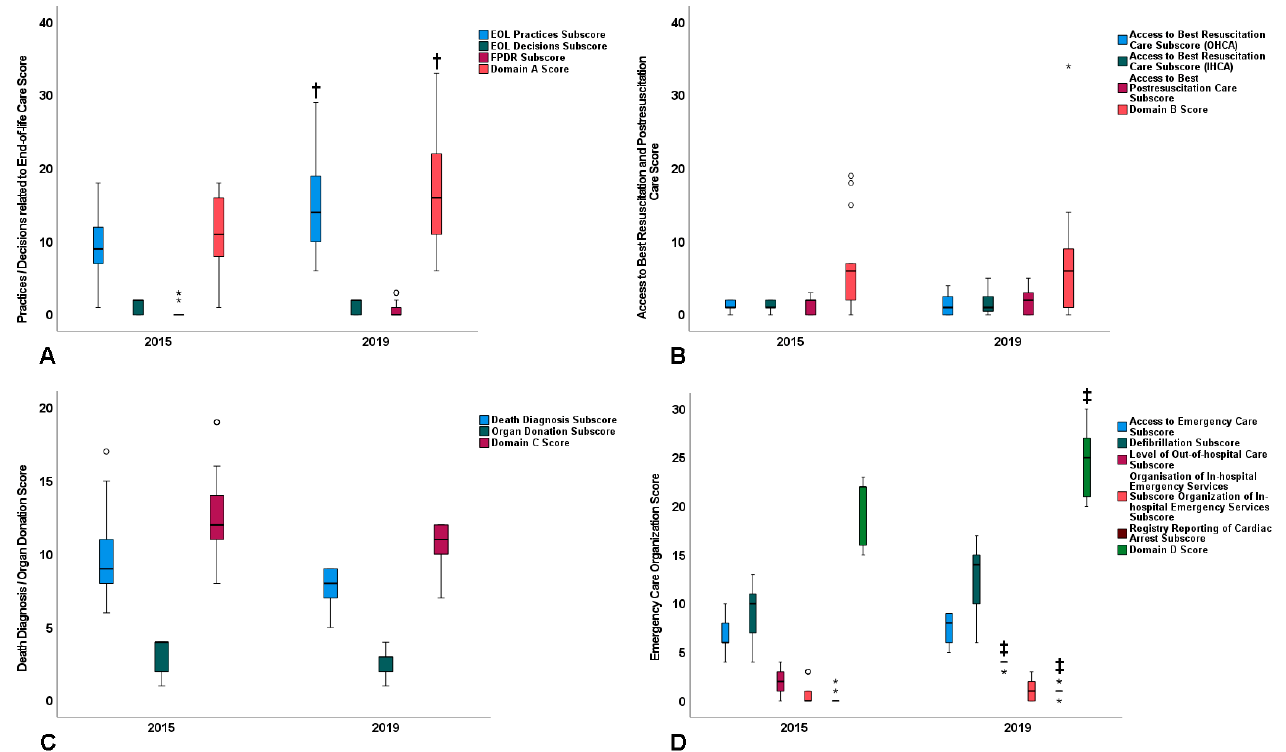
Figure 3. Summary results on the secondary study outcome. Boxplot presentation of subscores and scores of domains ( A – D ) of the study questionnaire. Data originate from countries with “low” 2015 domain scores (n = 13 for domains ( A , C ); n = 15 for domain ( B ); and n = 9 for domain ( D )). Bars reflect median value; box height reflects interquartile range; bars on top or bottom of the boxes reflect actual range of values; symbols (circles and asterisk) reflect countries with outlier score values, that is, score values outside the range that corresponds to box height plus the bars. †, p < 0.05 vs. 2015; ‡, p ≤ 0.01 vs. 2015.